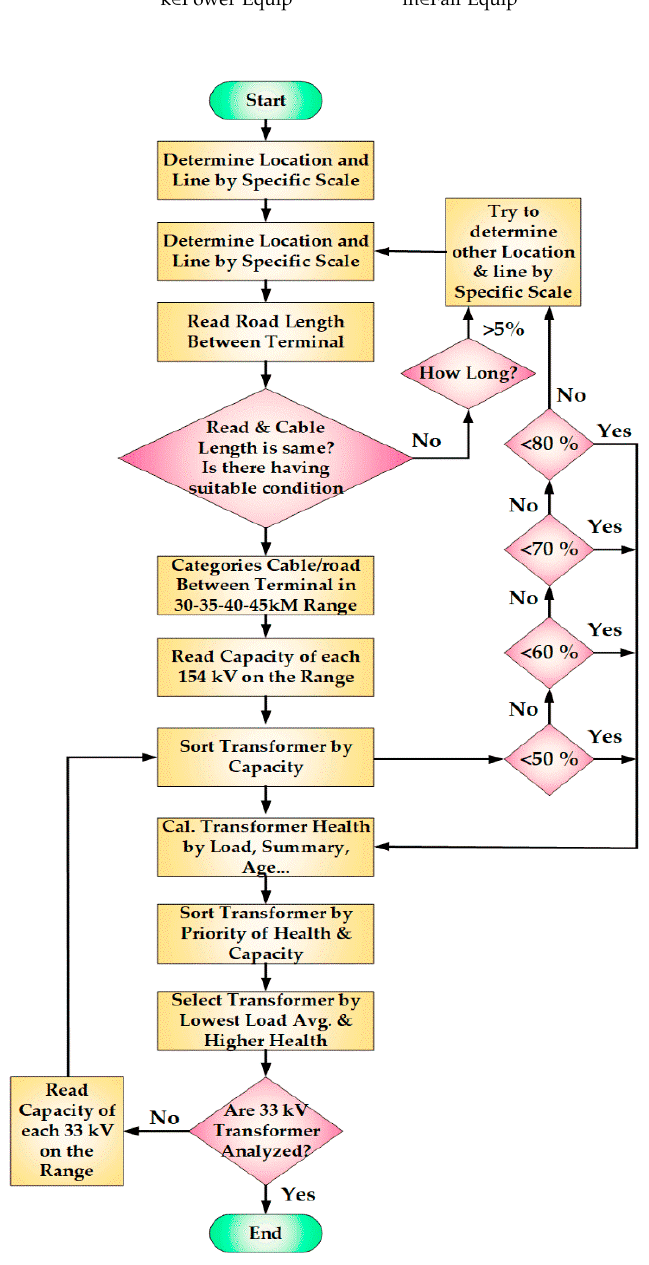
Figure 3. Electric vehicle (EV) charge stations coordination algorithm .